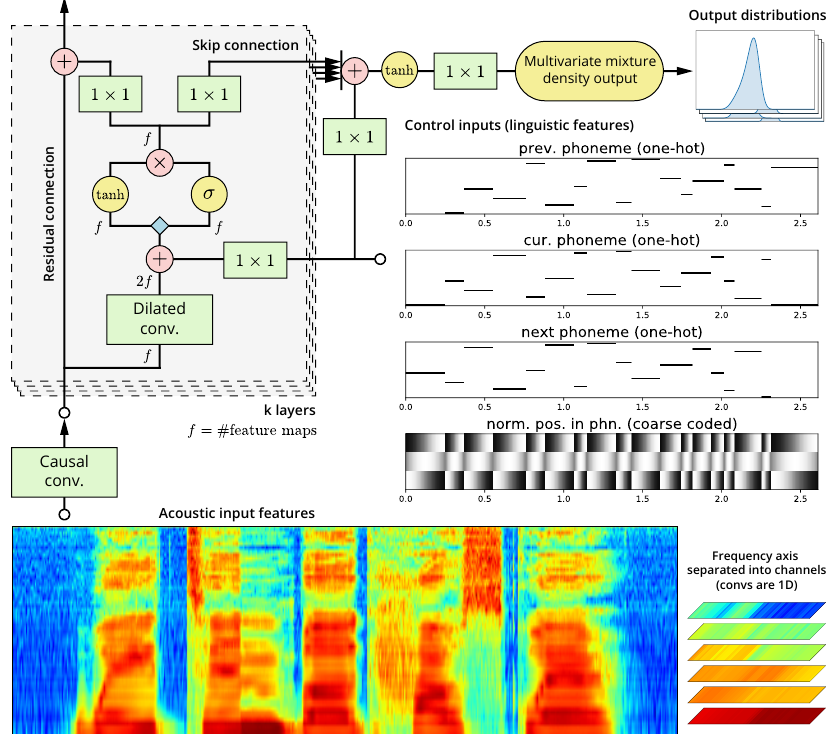
Figure 2. Overview of the modified WaveNet network architecture. In this case, the network depicted predicts harmonic spectral envelope features (top-right and bottom), given control inputs